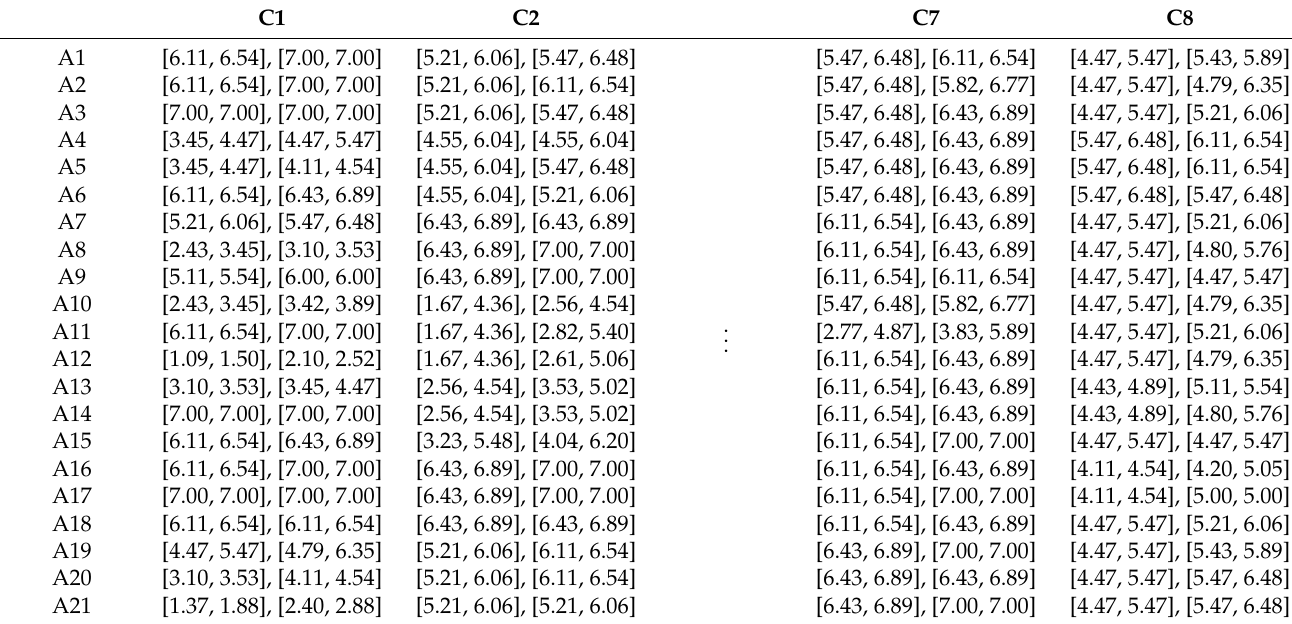
Table 6. Initial interval rough matrix for the IRN EDAS